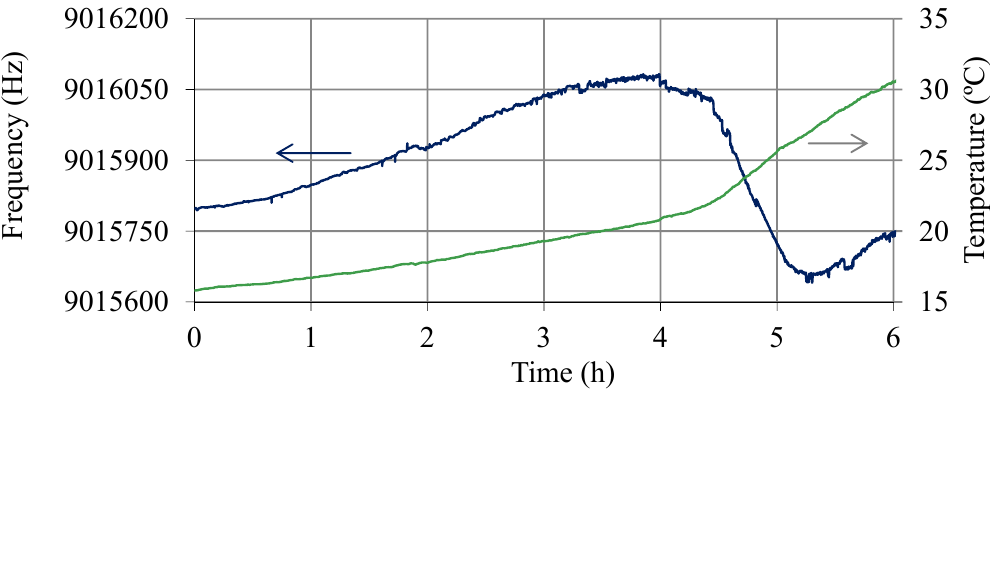
Figure 12. Oscillation frequency and temperature of the QCM sensor during a charge